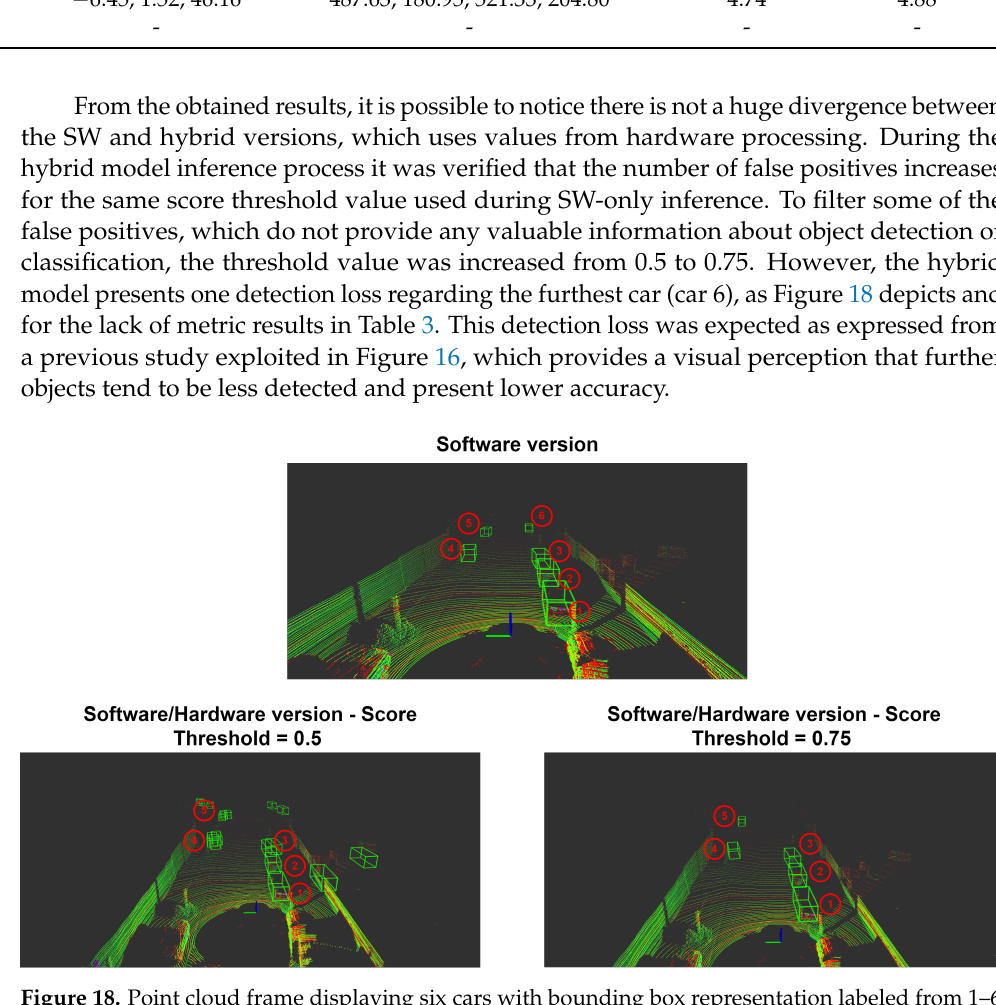
Figure 18. Point cloud frame displaying six cars with bounding box representation labeled from 1–6. SW–HW (hybrid) output detection for different score threshold value, left side with 0.5 and right side with